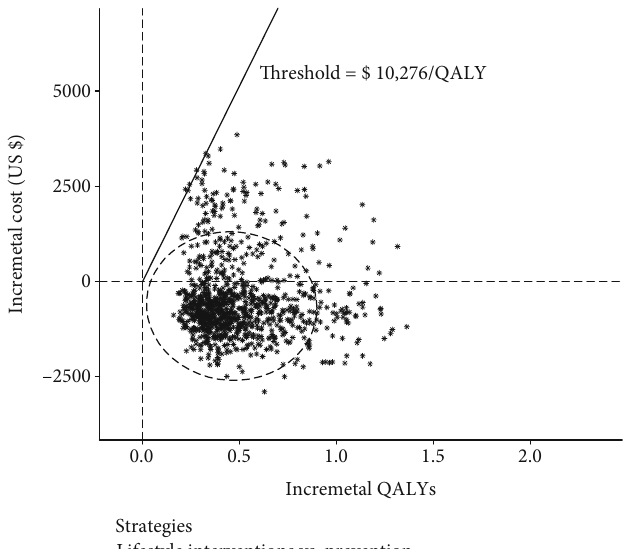
Figure 3: The probabilistic results of the incremental cost-e ff ectiveness di ff erence of lifestyle interventions versus no prevention. The dashed ellipses surround 95% of the estimates.